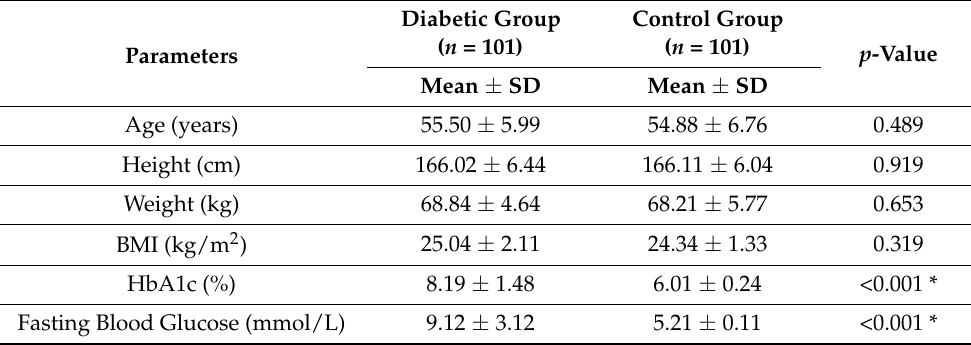
Table 1. Demographic and biochemical characteristics of diabetic patients compared to their matched control